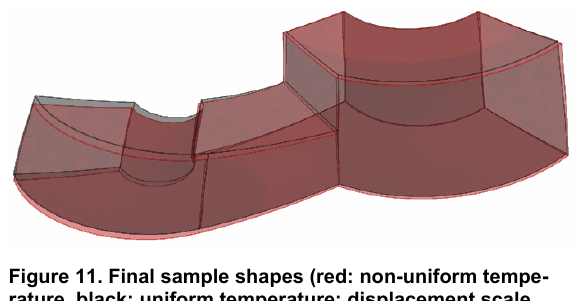
Figure 10. Displacements after sintering (model scaled 4 times)